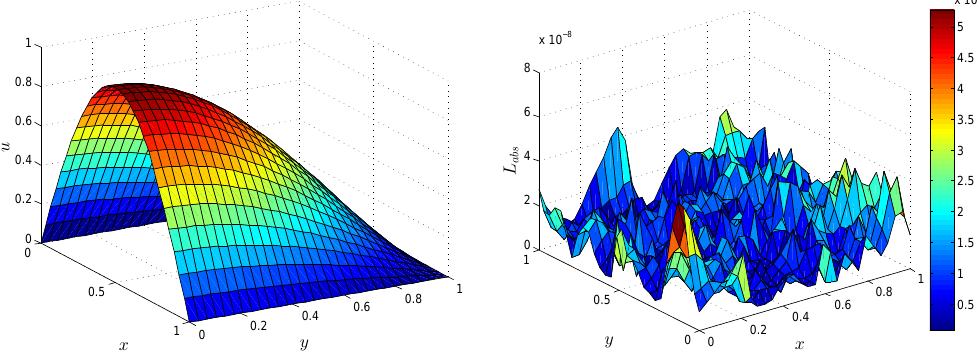
Figure 2. Numerical approximation ( left ) and L abs error norm ( right ) for Problem 2 for N = 400.